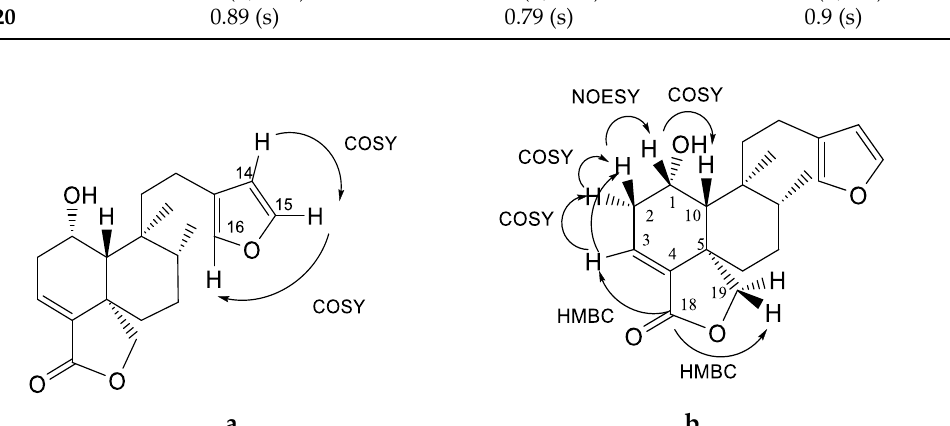
Figure 2. Correlations; ( a ) COSY and ( b ) COSY, NOESY and HMBC of compound 2 . 119